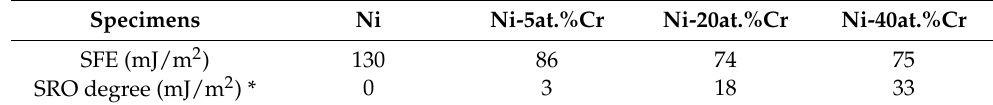
Table 1. SFE and SRO degree of Ni and Ni-Cr alloys [16–18].